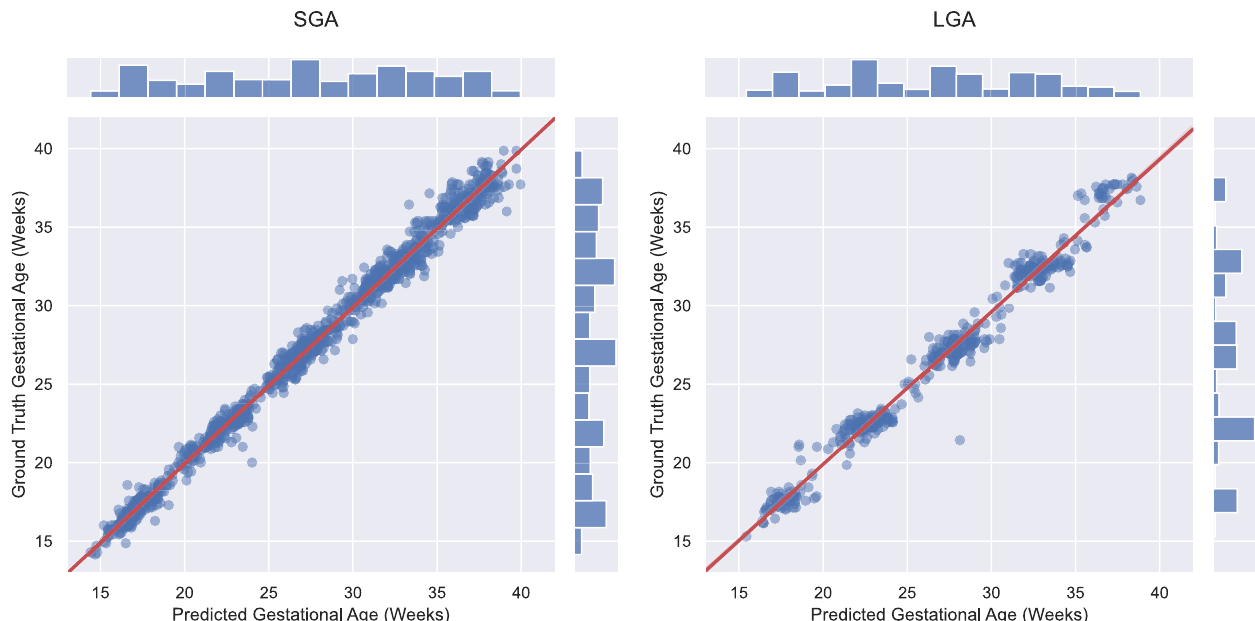
Fig. 4 MultiPlane performance in small and large for gestational age fetuses. Gestational age (GA) estimation results in pregnancies resulting in small for gestational age (SGA) or large for gestational age (LGA) newborns, de fi ned by a birth weight >90th centile (LGA) or <10th centile (SGA) according to the INTERGROWTH-21st international standard 30